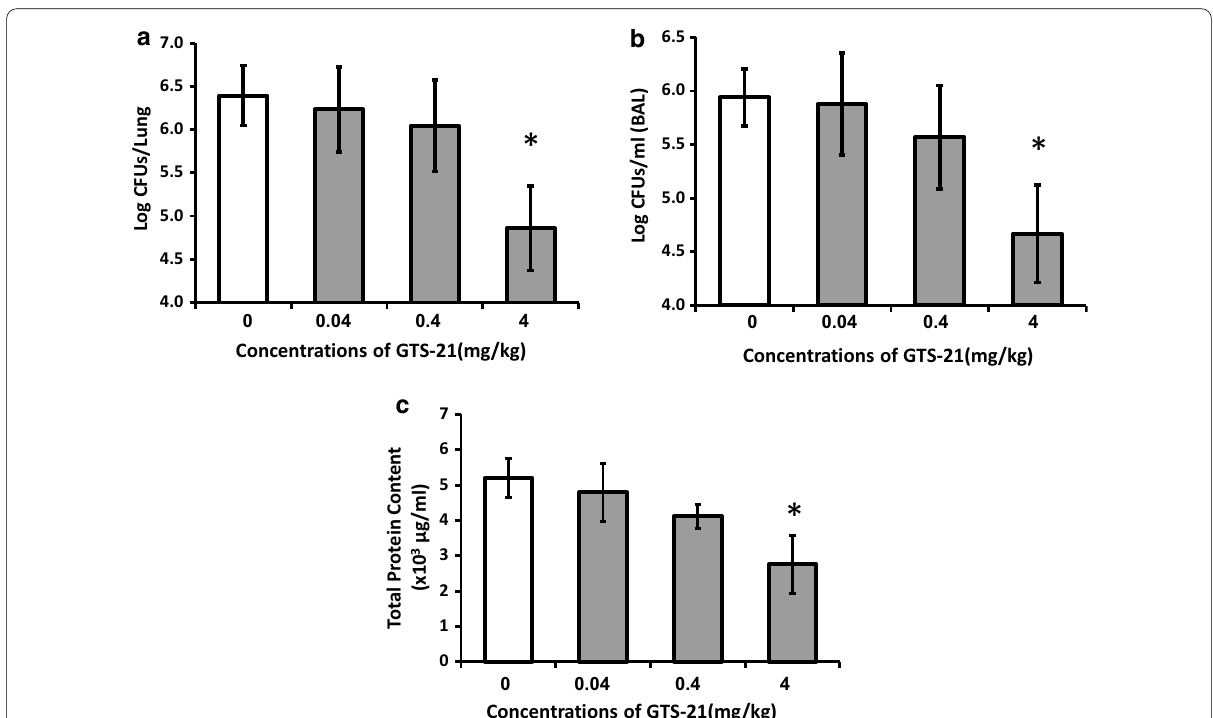
Fig. 1 Systemic administration of GTS-21 increases bacterial clearance and decreases acute lung injury in mice exposed to hyperoxia and challenged with PA. C57BL/6 mice were exposed to 99% O 2 for 48 h and then inoculated with PA (0.1 10 8 CFUs/mouse), and returned to 21% ≥ × O 2 after inoculation. Mice were randomized to receive either GTS-21 (0.04, 0.4, and 4 mg/kg) or saline, administrated by intraperitoneal injection, every 8 h starting at 32 h during hyperoxia. BAL and lung tissue were harvested 18 h after inoculation. Viable bacteria in the airways and lungs were quantified by plating serial dilutions of homogenized lung ( a ) and BAL ( b ), and are expressed as log CFUs/lung and log CFUs/ml of BAL, respectively. The total protein content in the BAL ( c ) was measured as a marker of lung injury. Data represent the means SEMs from two independent ± experiments (n 5 for control, n 6 for all GTS-21 treated mice). *p < 0.05, compared with mice receiving normal = =